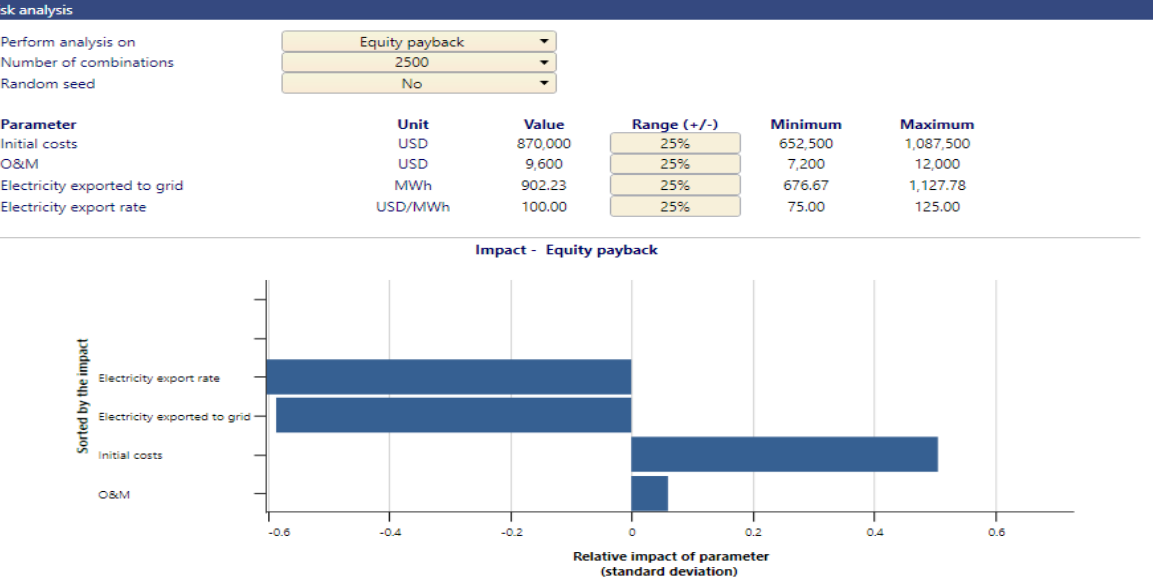
Table 8. Project fi nancial output parameters for an annual electricity rate of 0.1 USD/kWh.